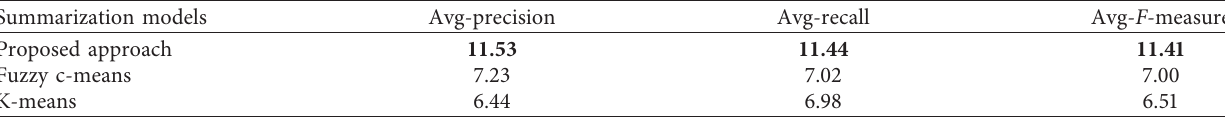
Table 2: Evaluation of summarization models on various measures using ROUGE-2 on Ubuntu dataset. Summarization